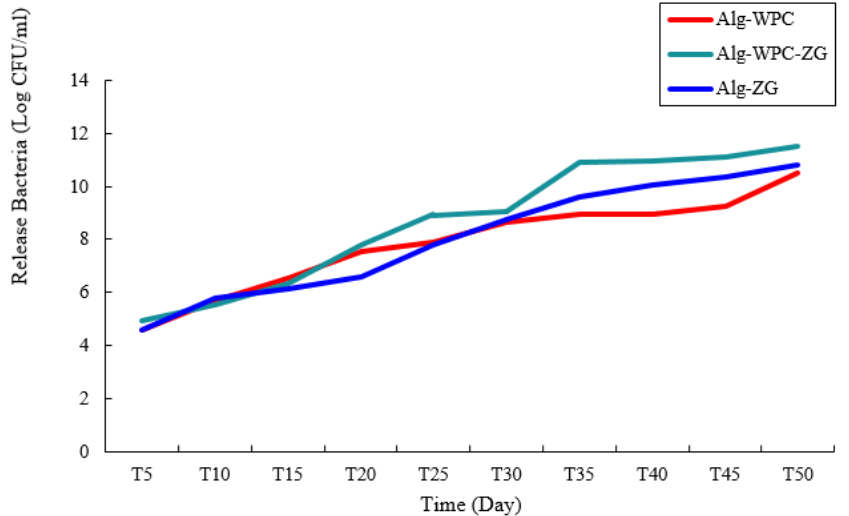
Figure 8. Release of B. velrzensis from microcapsules in phosphate buffer over 50